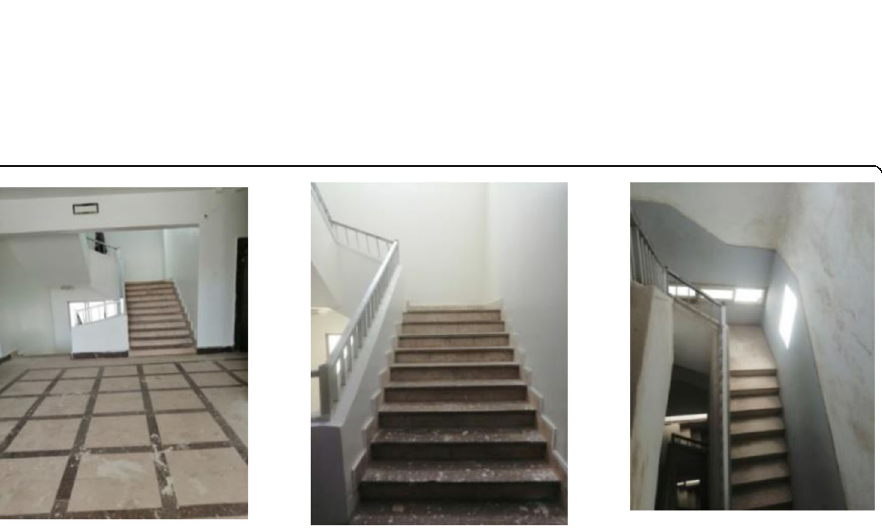
Fig. 11 The main stair is 1.7 m in width, while the emergency stair is 1 m in width (2020)